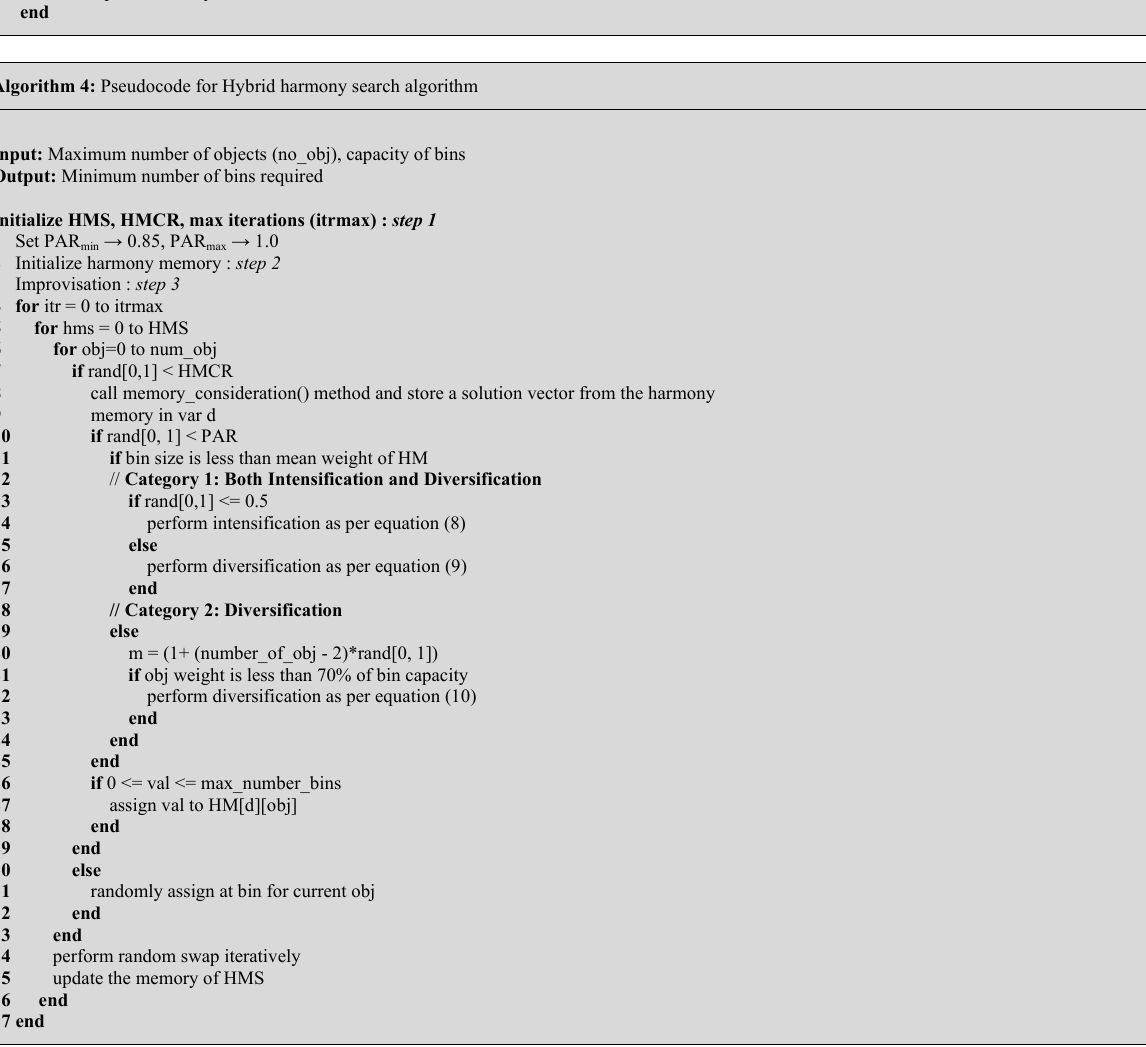
Algorithm 4: Pseudocode for Hybrid harmony search